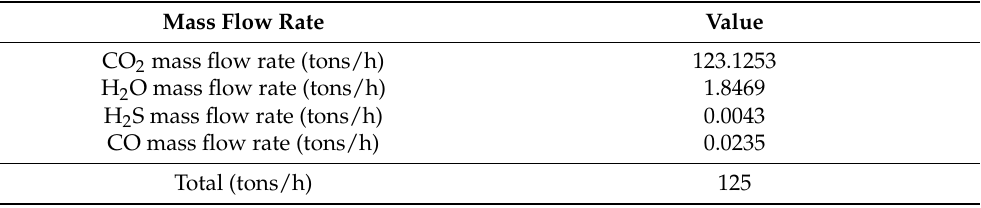
Table 1. Captured gas